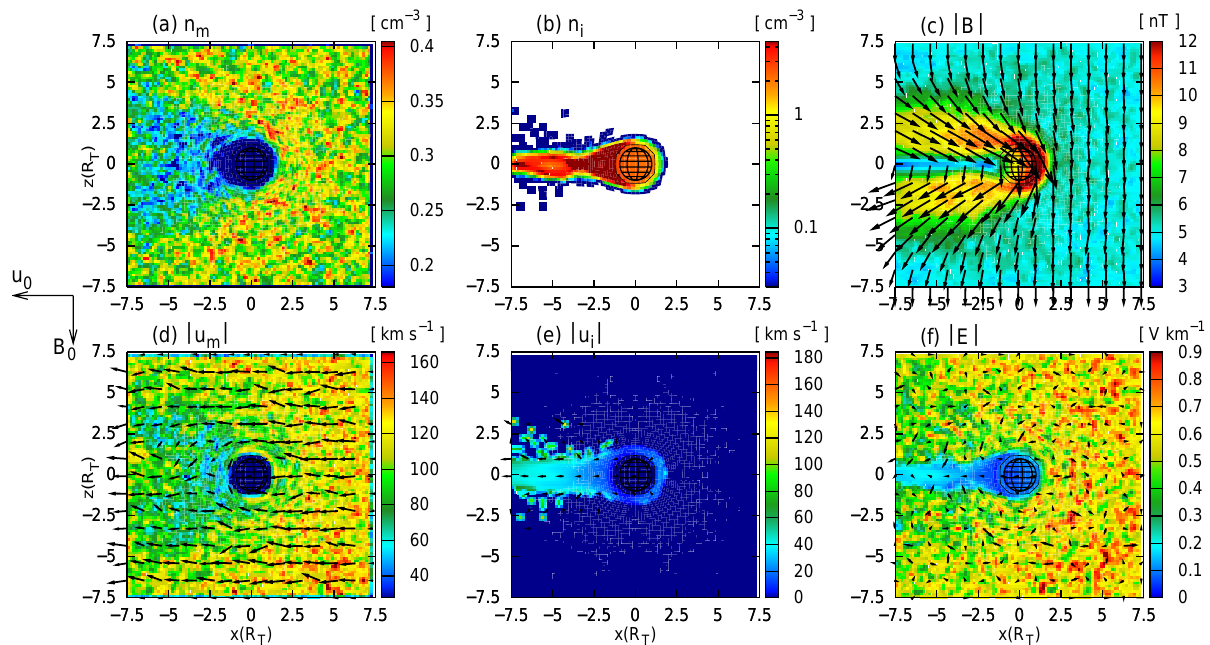
Fig. 14. Titan’s plasma environment at 06:00 Saturnian local time – cut through the (y,z) plane of the coordinate System, coinciding with Titan’s terminator plane. The figure displays (a) the magnetospheric ion density, (b) the ionospheric nitrogen density, and (c) the magnetic field. The global features of the interaction region, especially the asymmetry of the nitrogen tail with respect to the direction of the convective electric field, are in complete correspondence to the situation at 18:00 local